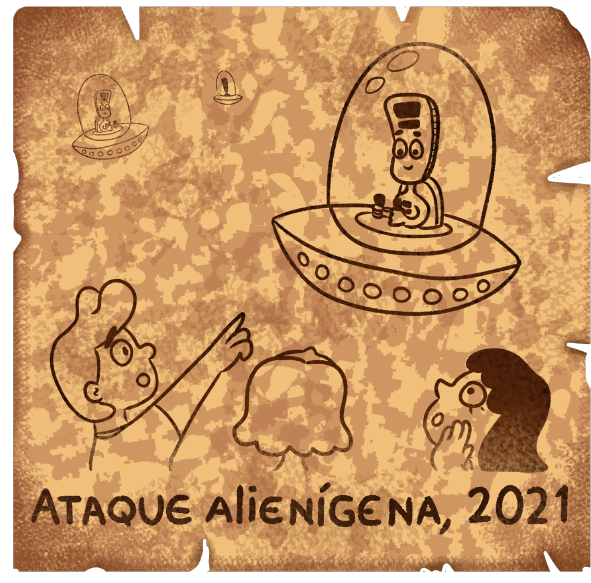
Figure 2. The story